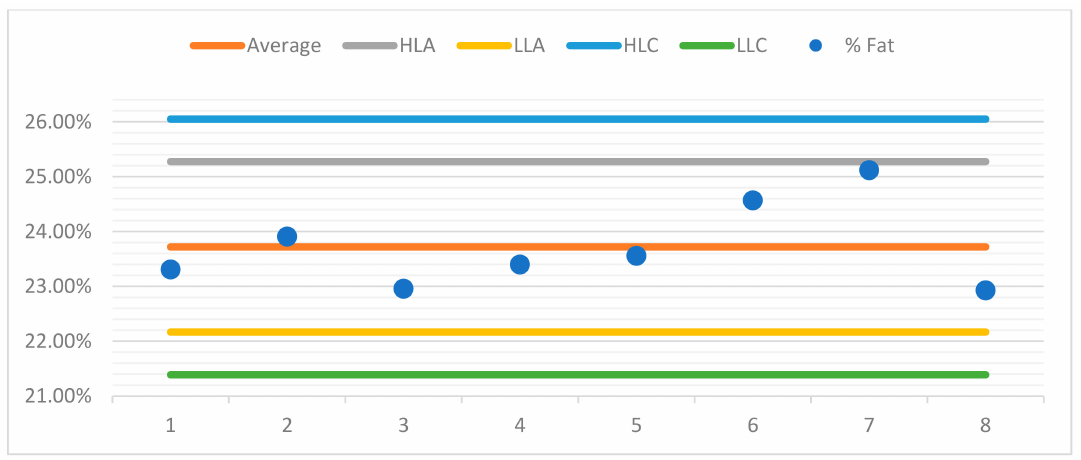
Figure 7. Control chart sample